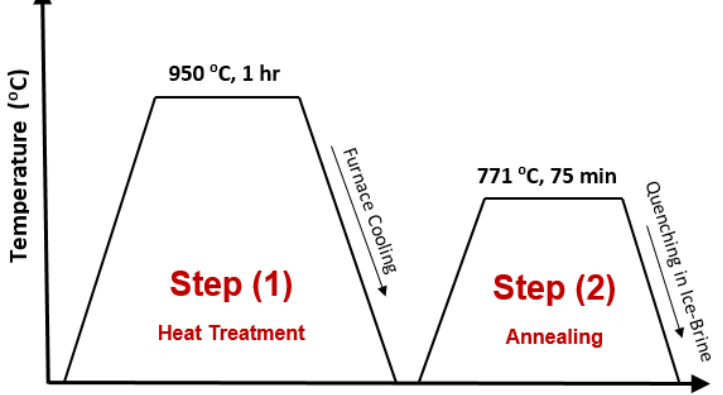
Figure 1. Heat treatment of dual phase (DP) rebar.